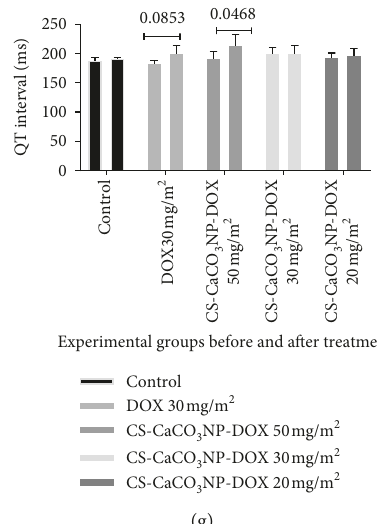
Figure 3: Electrocardiogram changes due to cumulative free DOX 150mg/m 2 and different CS-CaCO regimen ranging from 100 to 250mg/m 2 . (a) Ventricular rate, (b) PR interval, (c) P wave, (d) PII amplitude, (e) QRS duration, (f) QRS axis, and (g) QT interval. Values are expressed as mean ± standard deviation. p < 0 . 05 is considered